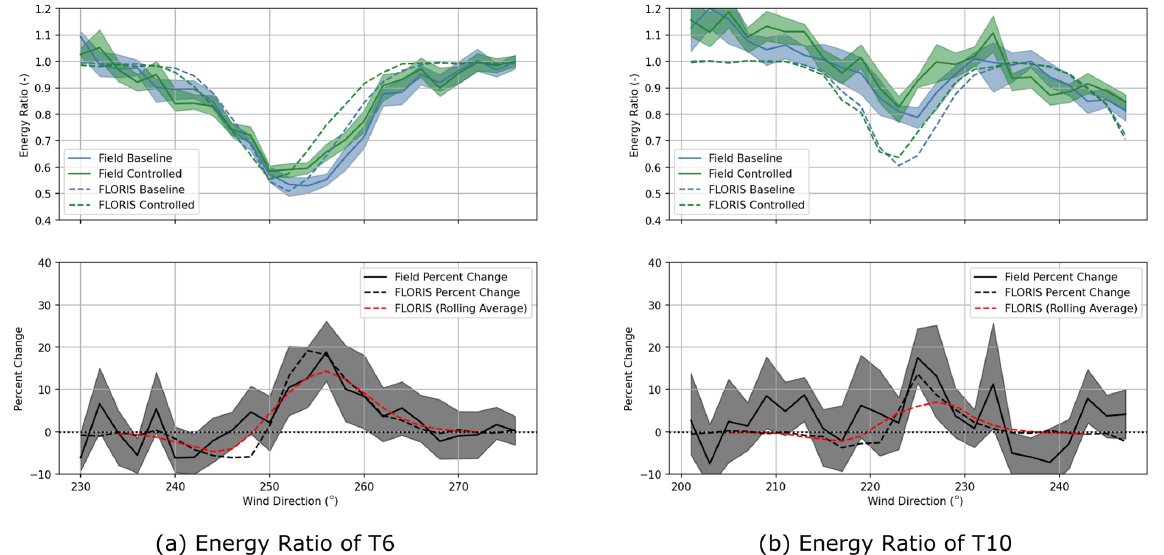
Figure 7. Comparing the energy ratios and percent change in energy ratio for test turbines T6 and T10, with respect to T4. The FLORIS values are indicated as dashed lines. In the percent change plot, the percent change in FLORIS is indicated in black, and the rolling window average is indicated in